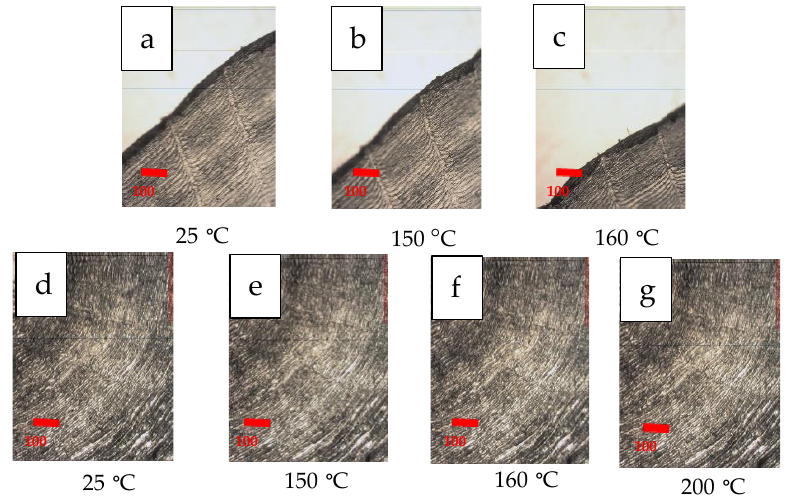
Figure 2. Temperature-dependent changes in collagen films and HAp-collagen composite films. Pictures ( a – c ) are extracted collagen films. Pictures ( d – g ) are HAp 40% HAp-collagen composite films synthesized using Method 2-2. In collagen images ( a , b ), there is still no change in the scale pattern and shape, but in ( c ), the pattern and shape have changed due to softening. The HAp-collagen composite film images ( d – g ) showed no change in scale pattern and shape.